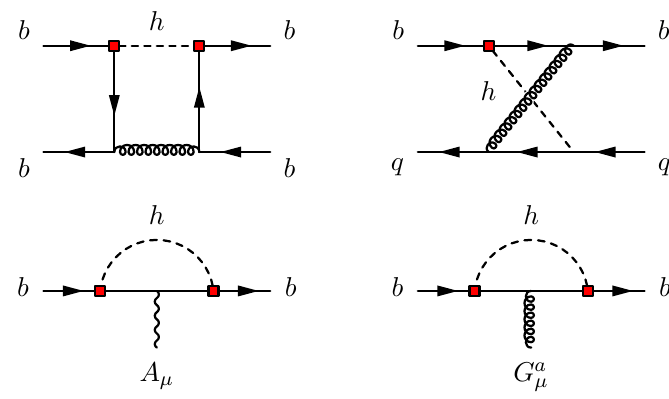
Figure 3 . Sample one-loop Feynman diagrams contributing to the calculation of the initial condi- tions of the RG evolution at the electroweak scale for the case of modified bottom-quark Yukawas (indicated by the red square). Light quarks are denoted by the label q = u, d, s